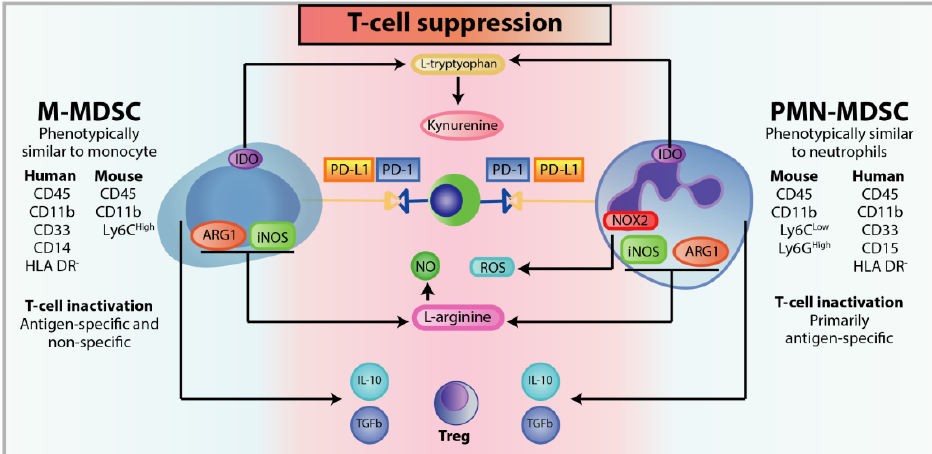
Figure 5. Mechanisms of T-cell suppression with phenotypic and functional differences